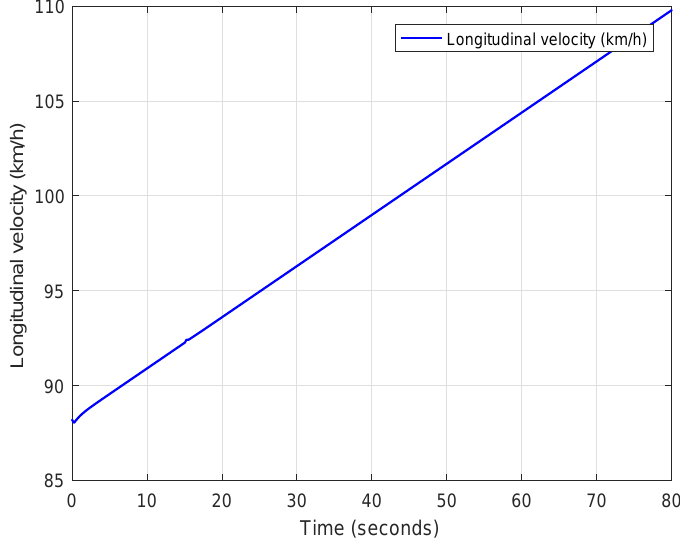
Figure 30. Variation of the longitudinal velocity in